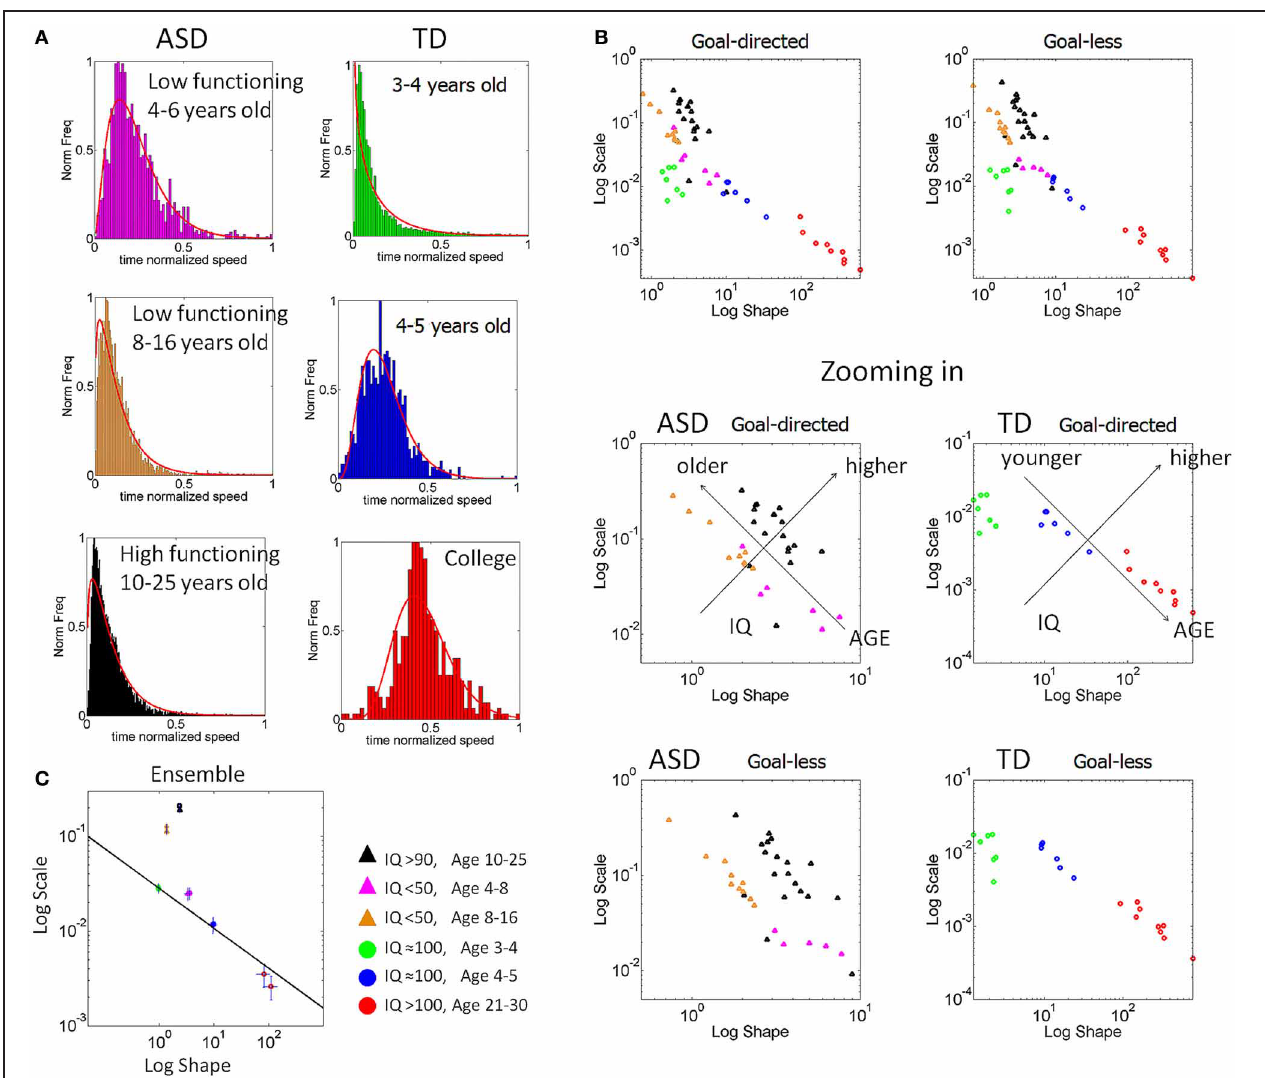
self-emerging clusters were blindly revealed by the patterns of micro-movements according to the average motion speed. The validation step coloring the scatter according to age and IQ, depicted in the legend, revealed a correspondence with the self-grouping. Bottom panels zoom in the scatters from forward and retraction hand movements. Notice that in ASD the age axis orients the older children away from the typical course of development. (C) The stochastic signatures of each cluster are well-characterized by a power relation fit through six points (goal-directed and goal-less for each TD group). The power relation spans several orders of magnitude on both axes (details of the goodness of fit in the main text). Notice again that the young ASD participants fall closer to the TD trajectory in stark contrast to the older verbal and non-verbal ASD participants who stray off the TD